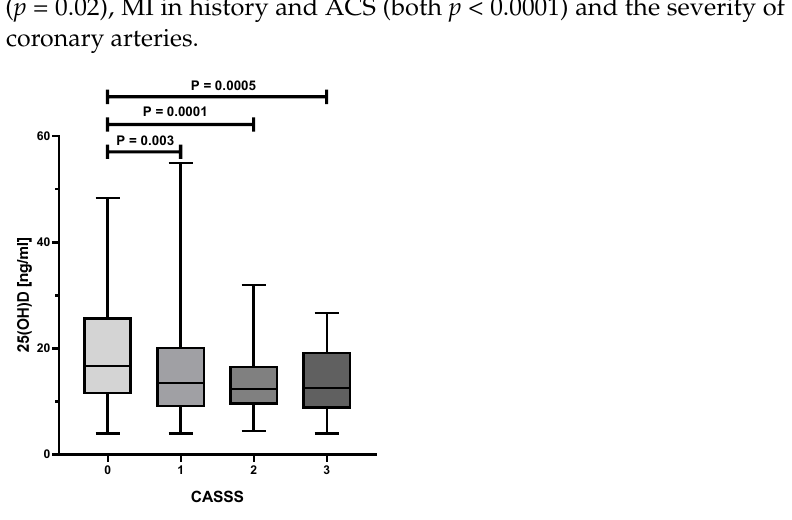
Figure 1. Differences between vitamin D level and Coronary Artery Surgery Study (CASS) score in postmenopausal women.